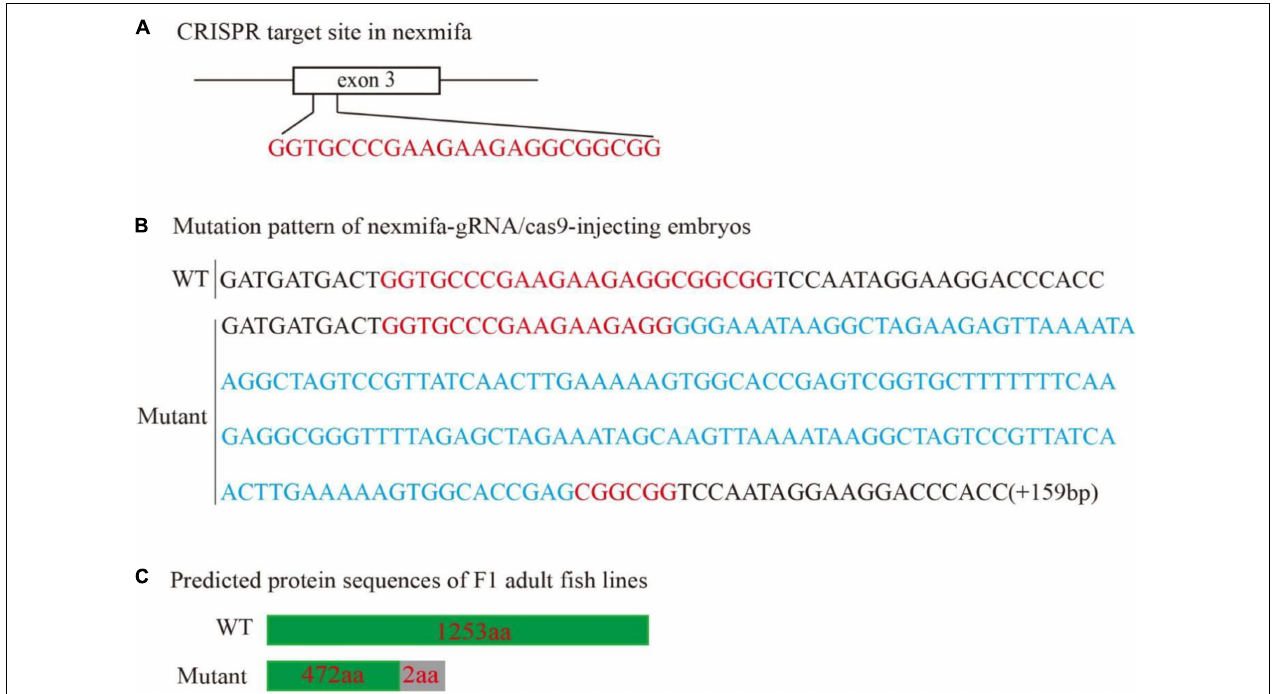
FIGURE 2 | Generation of the zebrafish nexmifa mutant using the CRISPR/Cas9 system. (A) Schematic showing the targeting site of the sgRNA in the third exon of nexmifa. (B) Mutation pattern of nexmifa-gRNA/cas9-injected embryos. Red letters represent the sgRNA sequence. Blue letters represent the additional 159 bp nucleotide sequence. (C) Schematic showing the predicted protein encoded by the mutated allele. Frameshift mutations resulted in truncated proteins. The gray rectangle indicates the wrong coded amino acid sequences.